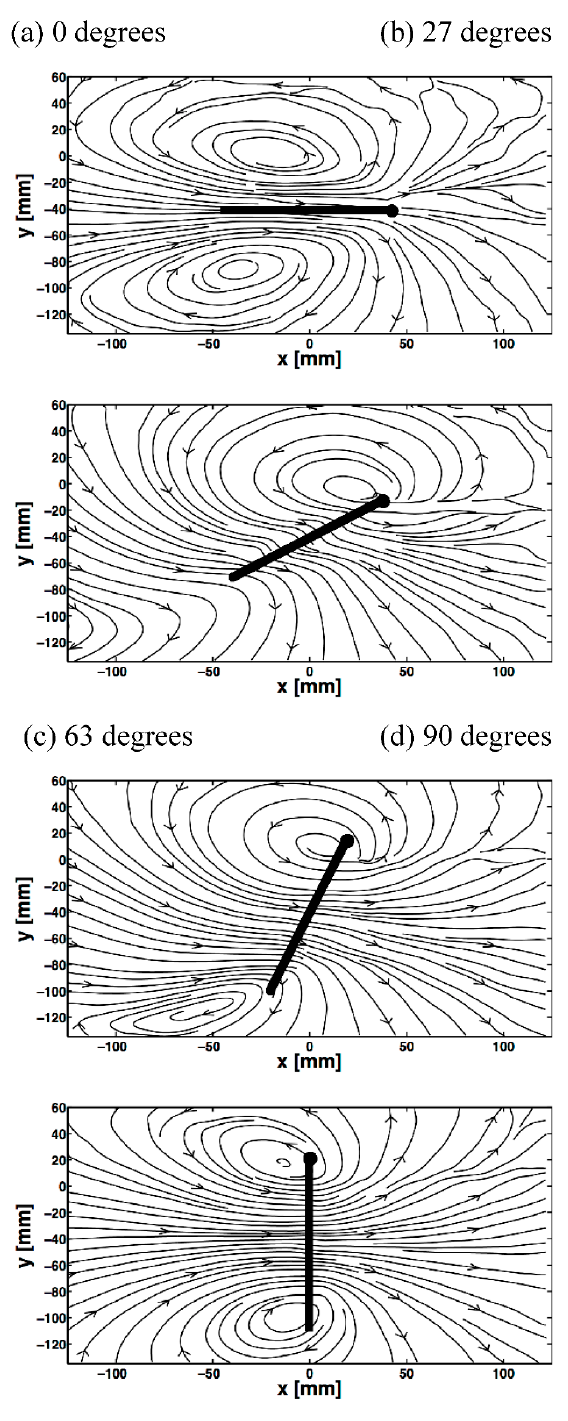
Figure A2. The flow visualization of the dynamically scaled wing using DPIV ( Re = 30) at ( a ) 0; ( b ) 27; ( c ) 63; and ( d ) 90 degree angles of attack. The light sheets were located at mid-span and parallel to the chord when the wing position was at 90° of the revolution stroke. Note that the wing is traveling to the right.